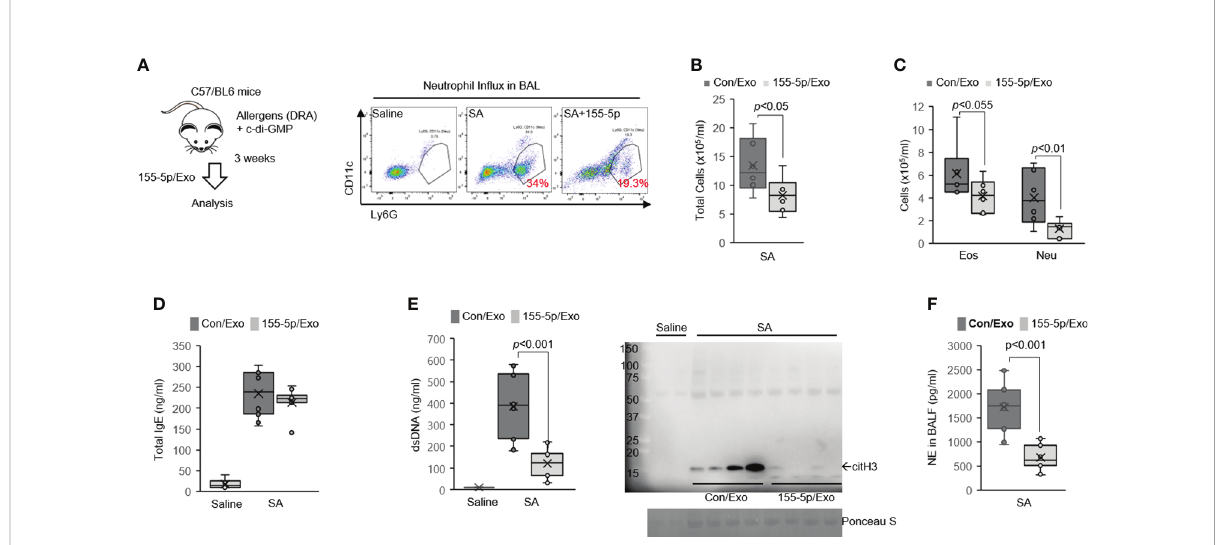
FIGURE 4 Delivery of miR-155 inhibitor has broad immunosuppressive potential in severe asthma (SA) mice. (A) Delivery of miRNA inhibitor via serum- derived exosomes into the lung macrophages in vivo . Serum exosomes measuring 100 m g transfected with 100 pmol of inhibitor control or miR-155 inhibitor (miR-155-5p) were given. Mice were sensitized and challenged with c-di-GMP and DRA and treated with miR-155 inhibitor or control on days 25, 26, and 27. Neutrophil in fl ux in BAL from SA mice is analyzed by fl ow cytometry (N = 5-7). (B) Total cells and (C) leukocyte differentials were counted in the BALF. (D) All SA animals had elevated levels of total IgE. (E) PicoGreen assay and Western immunoblot for citH3 showing ET-associated DNA present in BALF. (F) NE in the BALF of mice to the SA model. Graphs were plotted as mean ± SE. p-Values were obtained using a two-tailed Student ’ s t-test. BAL, bronchoalveolar lavage; BALF, bronchoalveolar lavage fl uid; ET, extracellular trap; NE, neutrophil